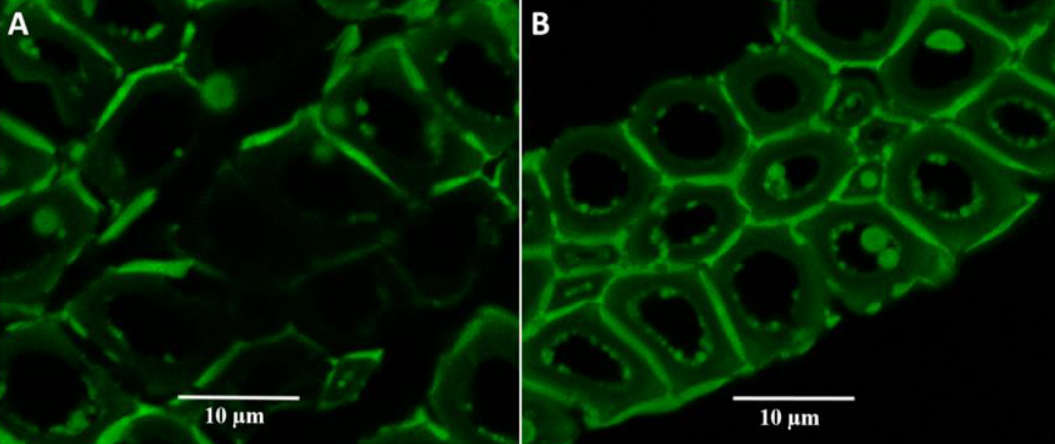
Figure 5. LSCM image. Images of areas with different lignin distributions in pre-treated material at severity S 0 10.42. ( A ) A zone with highly delignified fibres; and ( B ) micro and nano drops of lignin lodged inside the cell lumen.